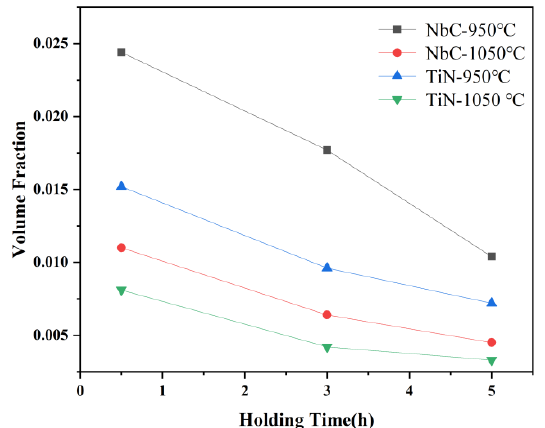
Figure 11. The volume fractions of the two types of precipitates under different austenitizing iso- thermal treatments.